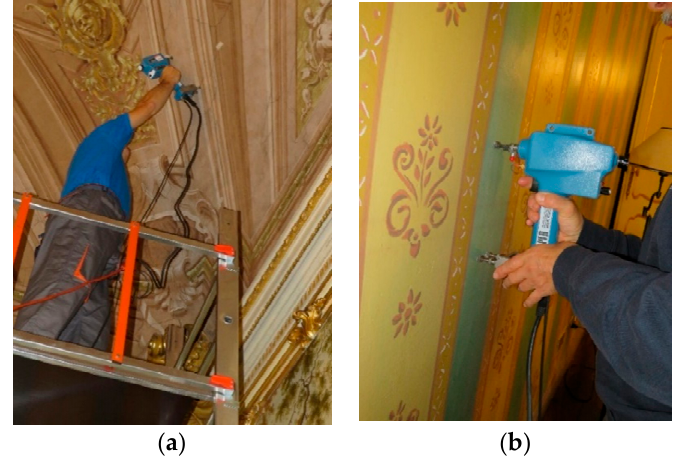
Figure 5. ( a ) Use of the electric impact hammer for the adherence test of the frescoed plaster of the masonry vaults at Birago Palace; ( b ) calibration test where it is possible to see the positioning of the electric impact hammer on the test surface.